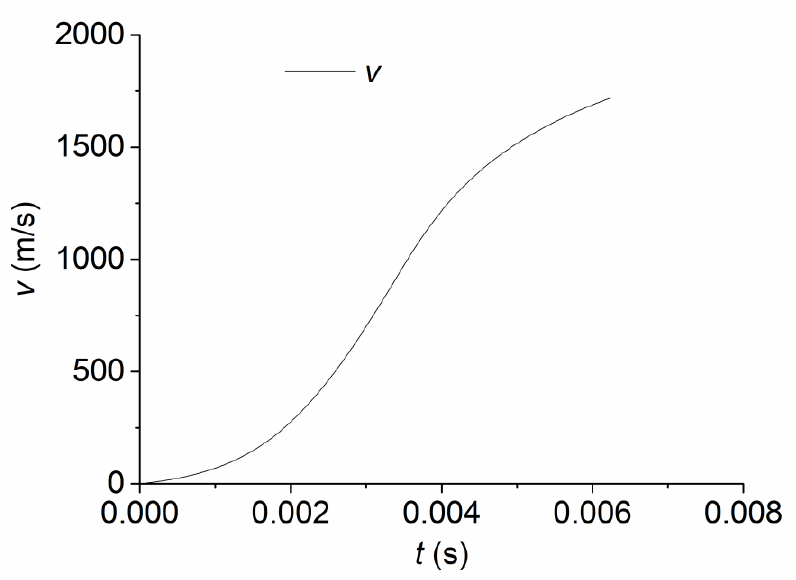
Appl. Sci. 2020 , 10 , 1468 Figure 3. Velocity-time curve of the shell moving in barrel. Figure 3. Velocity-time curve of the shell moving in barrel.